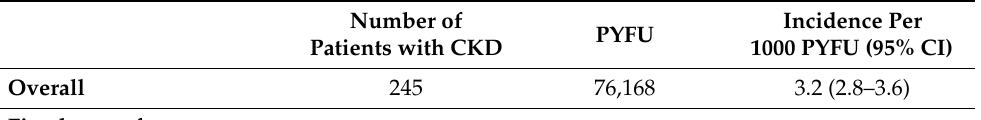
Table 2. Incidence per 1000 person-years of follow-up (PYFU) of chronic kidney disease according to the baseline characteristics among 27,313 HIV-infected adults who received one of the first-line antiretroviral therapy regimens followed for a median 2.3 years in the